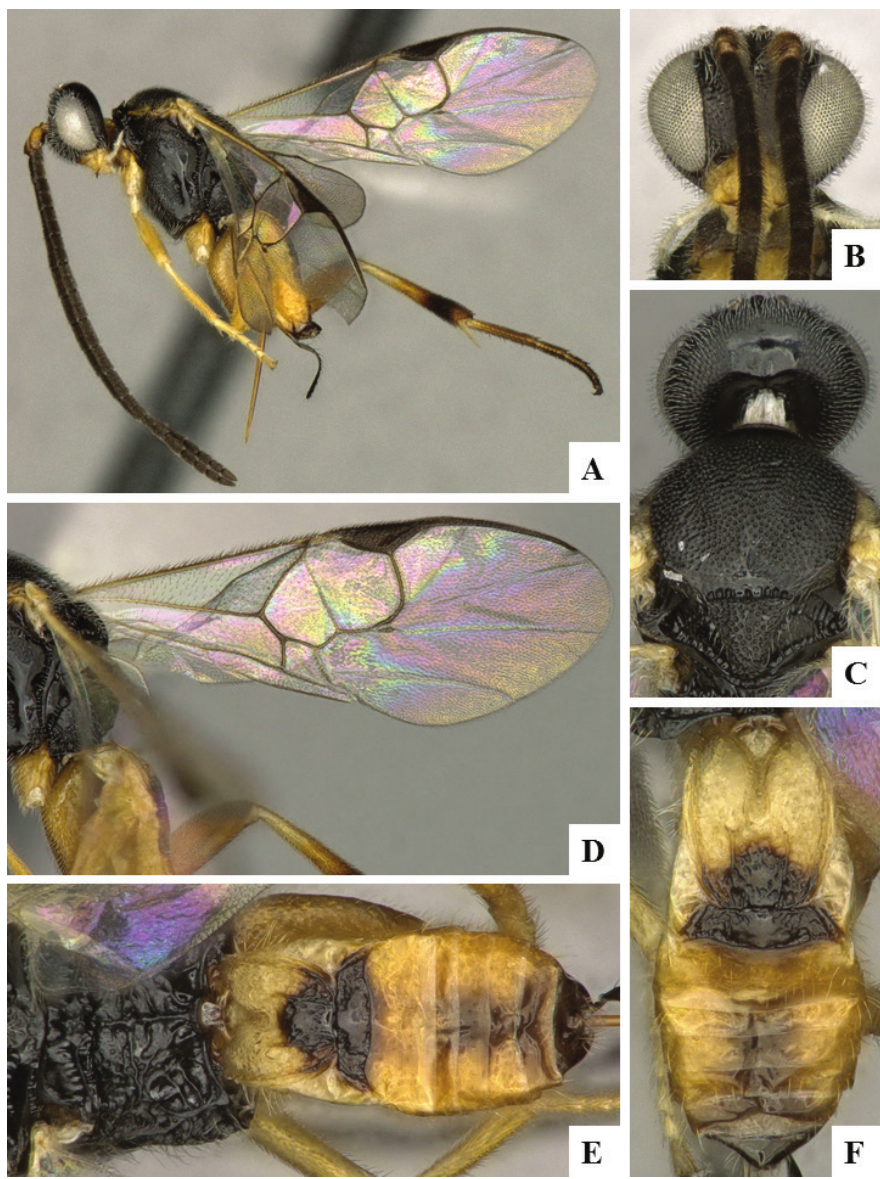
Figure 17. Janhalacaste winnieae female holotype. A Habitus B Head frontal C Mesosoma dorsal D Fore wing E Propodeum F Metasoma